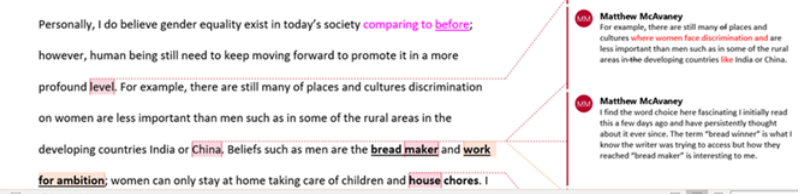
Figure 3. A sample of group corrections during the process of argumentative essay writing When the drafting was complete, Van organized the class as a gallery where students of all groups could mingle and provide feedback on each other’s work, using the rubrics they had worked on from the beginning of the